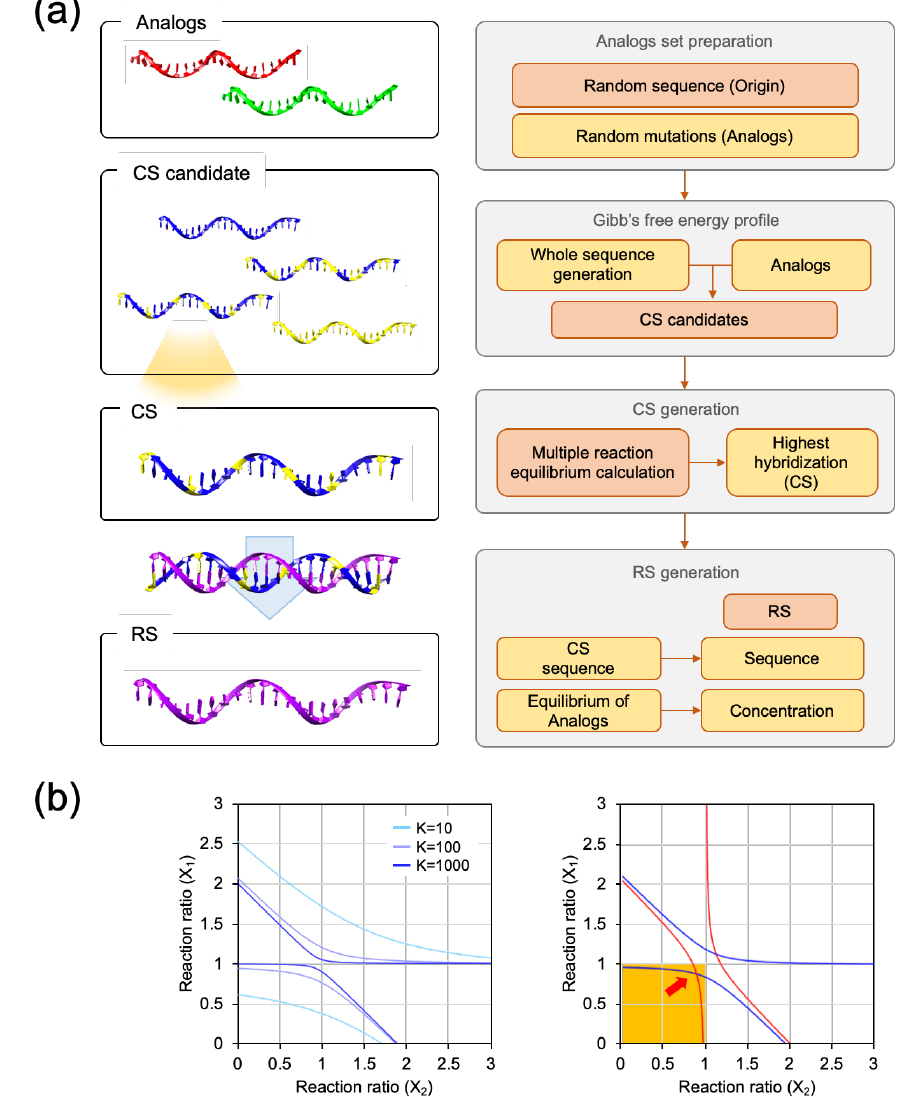
Figure 2. ( a) The flowchart for calculating the representative sequence (RS) from two analogs. In the complementary validation process, the modified nearest-neighbor model was used. The RS was obtained from the top-rated common complement sequence (CS), and the concentration was adjusted to create an equal amount of hybridization between the analogs. ( b) The hyperbola graph was obtained from a multiple reaction equilibrium constant calculation, and the hyperbola graph approaches the (1,1) coordinate with the increment in the reaction constant (K). The cross-point of two hyperbola indicates the equilibrium state of the reaction. Reasonable values that were lower than (1,1) were chosen for the summation of the hybridization yield.